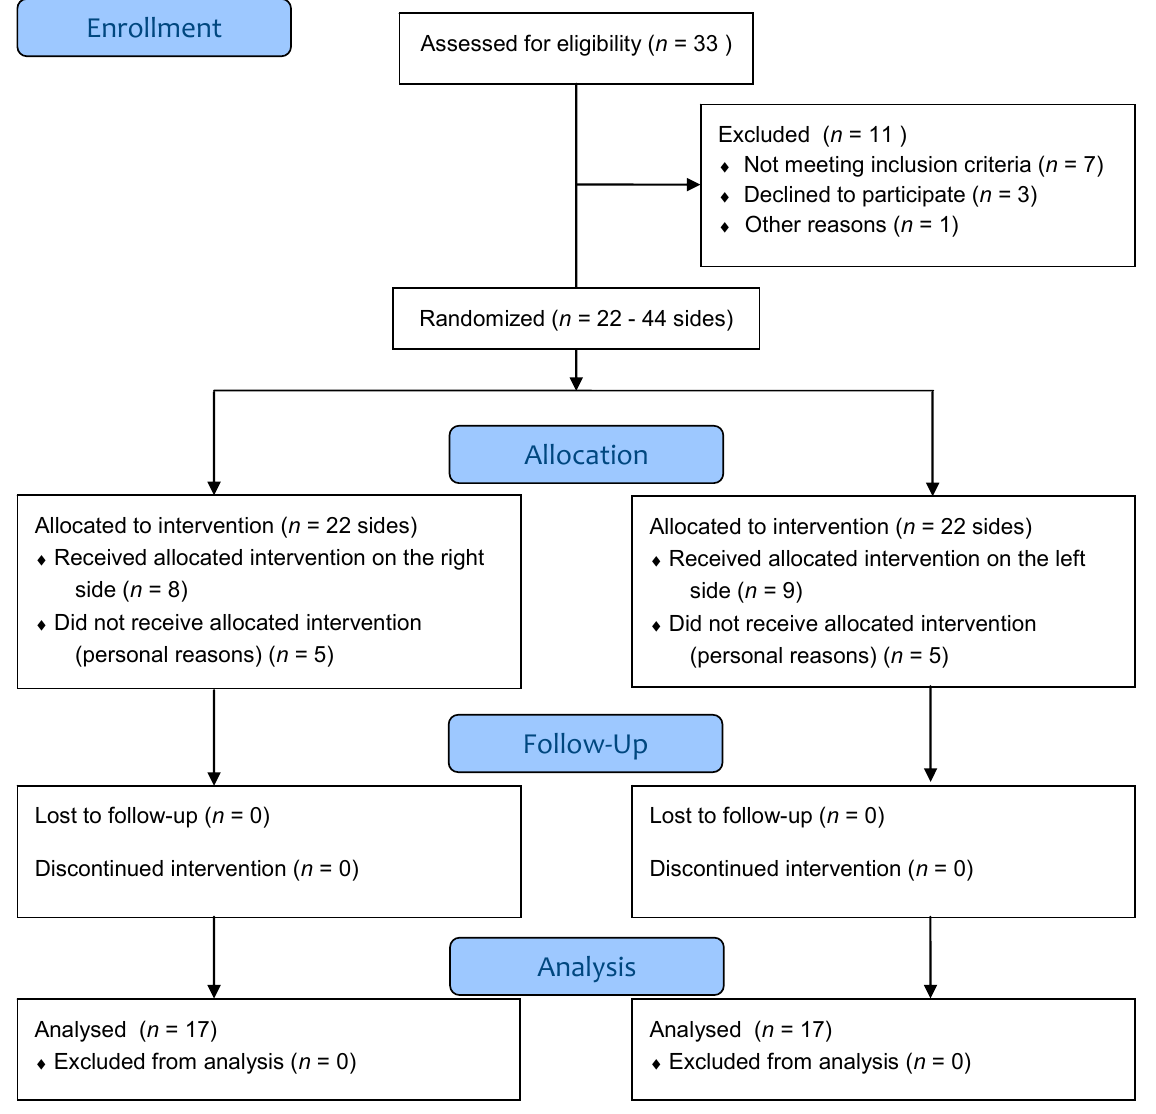
Figure 2. Flow Diagram. Table 2. Subjects’ baseline